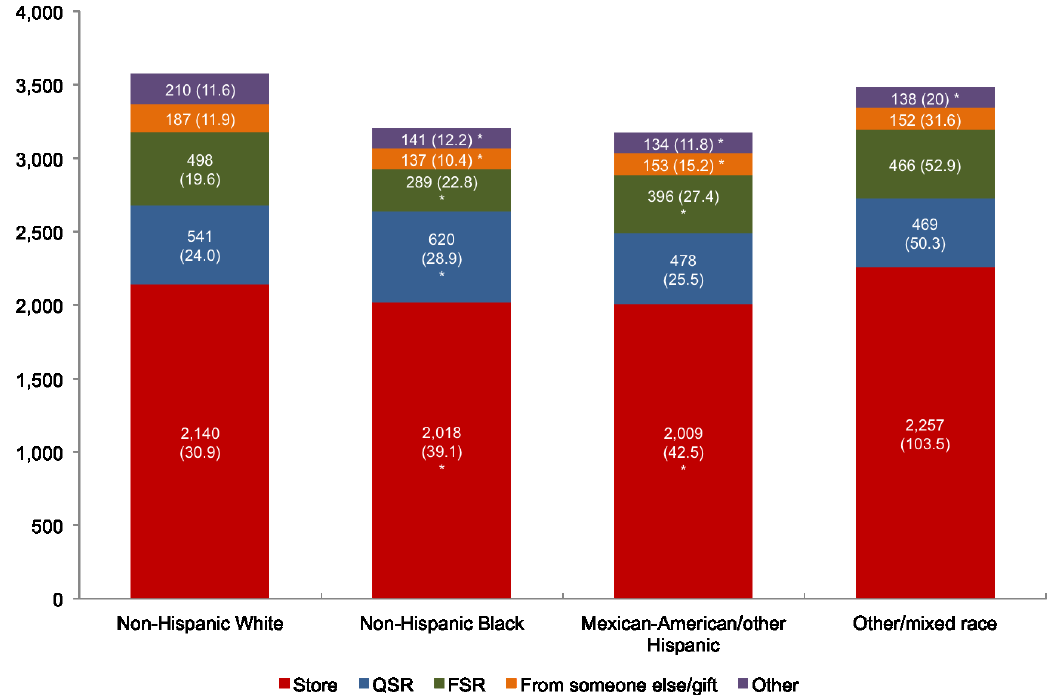
Values in parentheses represent standard errors of the age-adjusted survey-weighted mean. Asterisk (*) indicates value significantly different than value observed for non-Hispanic